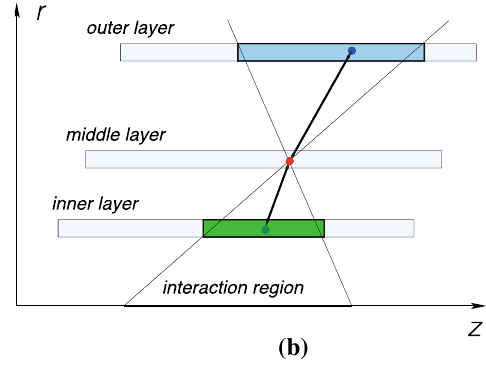
Fig. 6 Schematic illustrating a the track seed formation in radial bins and azimuthal sectors, where the midpoint sector for a triplet is the sec- tor containing the midpoint, and where the inner and outermost hits are allowed to originate in the same sector, or the the adjacent sectors, and